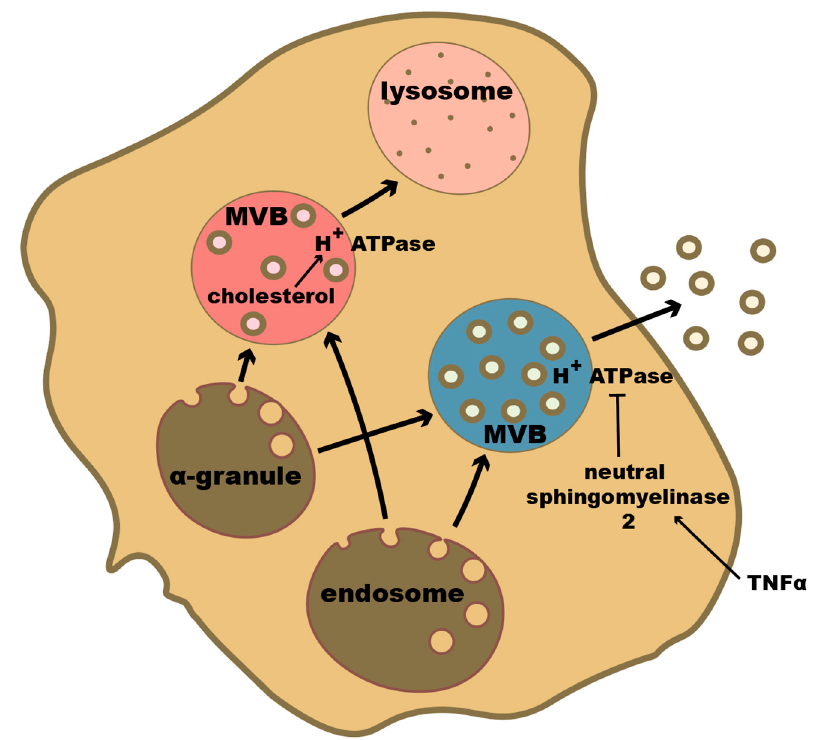
Figure 2. Effect of pH on Exosome Biogenesis. When the endosome, or the α -granule in platelets, undergoes invagination of its membrane, a multivesicular body (MVB) is formed. An acidic pH in the MVB destines the created exosomes for degradation via the lysosome, while a more basic pH destines the exosomes for secretion. H + ATPase controls the acidification of the MVB. Cholesterol in the MVB activates H + ATPase creating an acidic environment. On the other hand, TNF α activates neutral sphingomyelinase 2 which in turn inactivates H + ATPase leading to a more basic pH within the MVB.